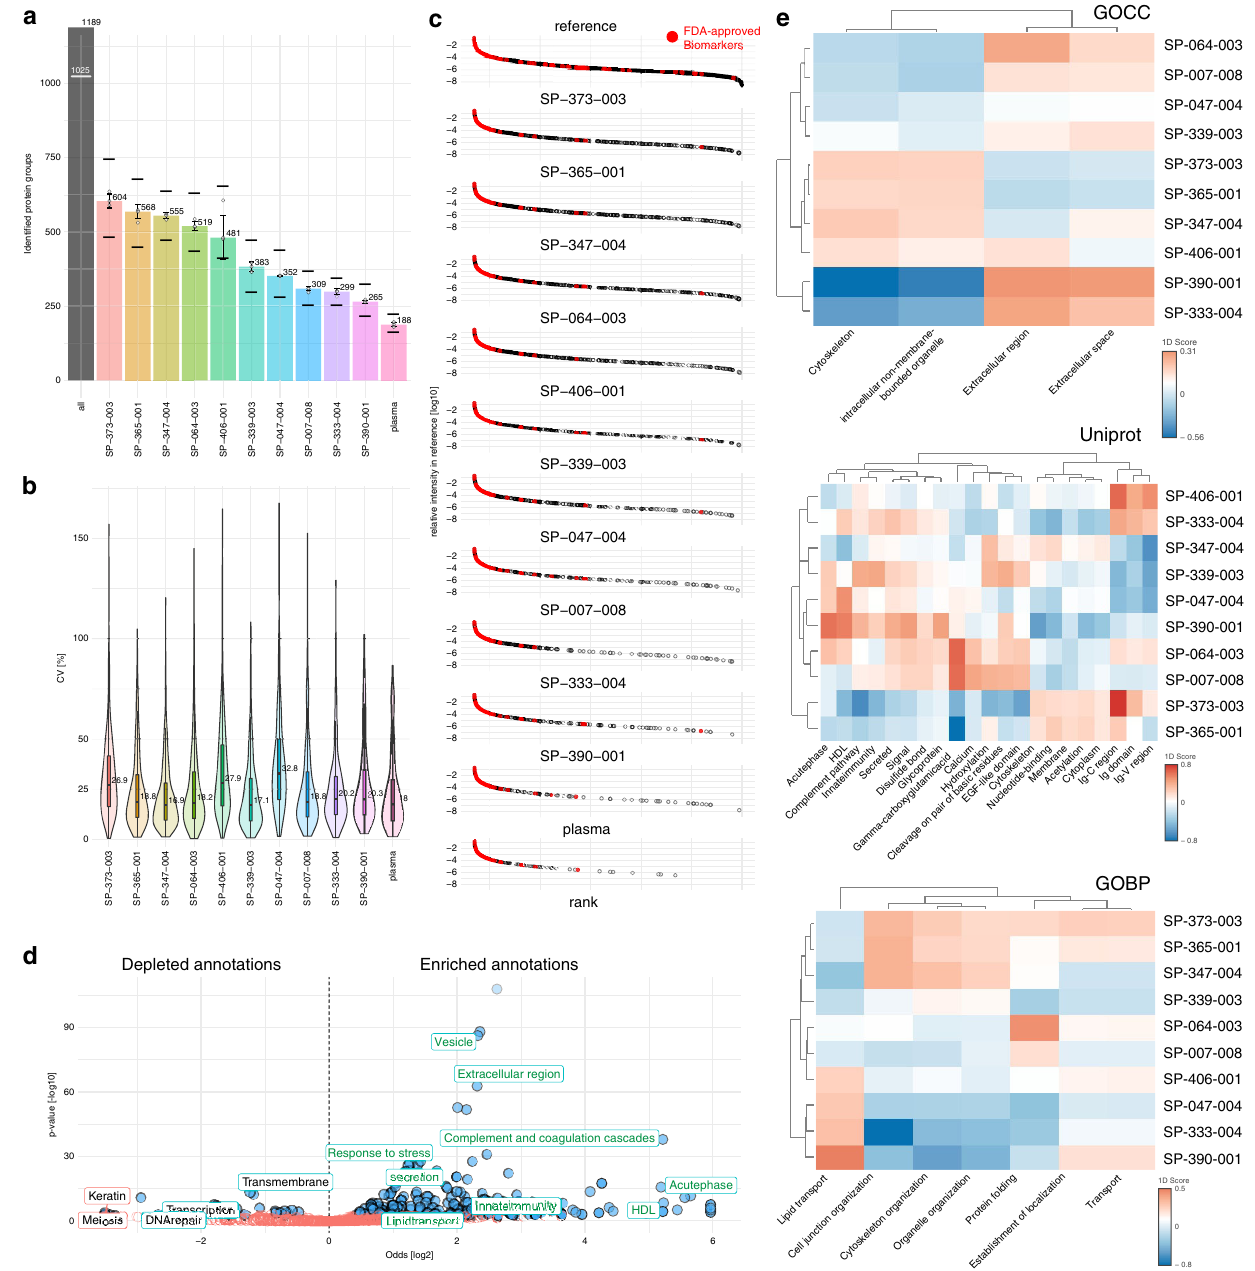
Fig. 4 Optimized panel of 10 SPIONs in comparison to neat plasma. a Protein groups from the NP corona of 10 SPIONs, quanti fi ed by DDA LC-MS/MS (1% protein and peptide FDR). All: number of quanti fi ed protein groups across all NPs (excluding neat plasma). White line indicates the number of proteins detected with two or more peptides with at least one NP. For respective NPs median count and standard deviation across three assay replicates are shown as bar plots. Upper dashes depict number of proteins detected in any sample; lower dashes depict number of proteins detected in all three replicates. White circles show number of protein IDs for each assay replicate. b CV% distribution (precision) of the NP protein corona-based work fl ow for neat plasma and 10 SPIONs ( fi ltering for three out of three valid values across assay replicates). Inner boxplots report the 25% (lower hinge), 50%, and 75% quantiles (upper hinge). Whiskers indicate observations equal to or outside hinge ± 1.5 * interquartile range (IQR). Outliers (beyond 1.5 * IQR) are not plotted. violin plots capture all data points. c Matching 10 SPIONs to a plasma protein database of MS intensities. Ranked intensities for the database proteins 5 are shown in the top panel. Most intense protein is in the upper left corner of the panel; least intense is in the lower right corner. Intensities for proteins from neat plasma are shown in the bottom panel (plasma). Intensities for 10 SPIONs are shown in the remaining panels. Red dots indicated FDA- approved protein biomarkers 1 . d Volcano plot depicting annotation enrichment analysis (Fisher ’ s exact test) for functional pathways (GOCC,GOBP, KEGG, Uniprot Keywords, Pfam) of proteins detected in the optimized panel of 10 NPs in comparison to the database. Enriched = Log2 Odds > 0; depleted = Log2 Odds < 0. Blue circles indicated pathways with a Benjamini – Hochberg (B.H.) false discovery rate (FDR) < 1%. Green annotations indicate some enriched annotations enriched for NPs. Selected depleted annotatons are depicted in black. Keratin and Meiosis are depleted annotations with a B.H. FDR > 5%. e 1D annotation enrichment analysis comparing the protein intensity distribution (median intensity across assay triplicates, requiring three out of three quanti fi cations) of each NP against the average of all. 1D scores are plotted as heat maps for annotations (minimal size 11) that are signi fi cantly enriched or depleted (2% B.H. FDR) for at least 1 NP. All data were acquired in n = 3 independent assay replicates. Source data are provided as a Source Data fi